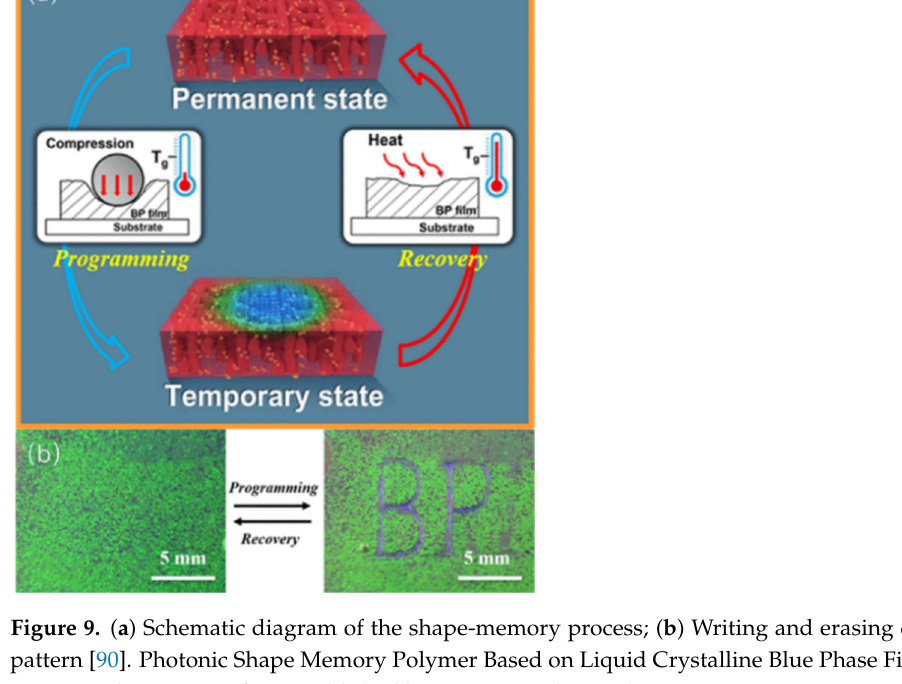
Figure 9. ( a ) Schematic diagram of the shape-memory process; ( b ) Writing and erasing of the BP pattern [90] . Photonic Shape Memory Polymer Based on Liquid Crystalline Blue Phase Films from Yang, Appl Mater Interfaces, published by American Chemical Society.